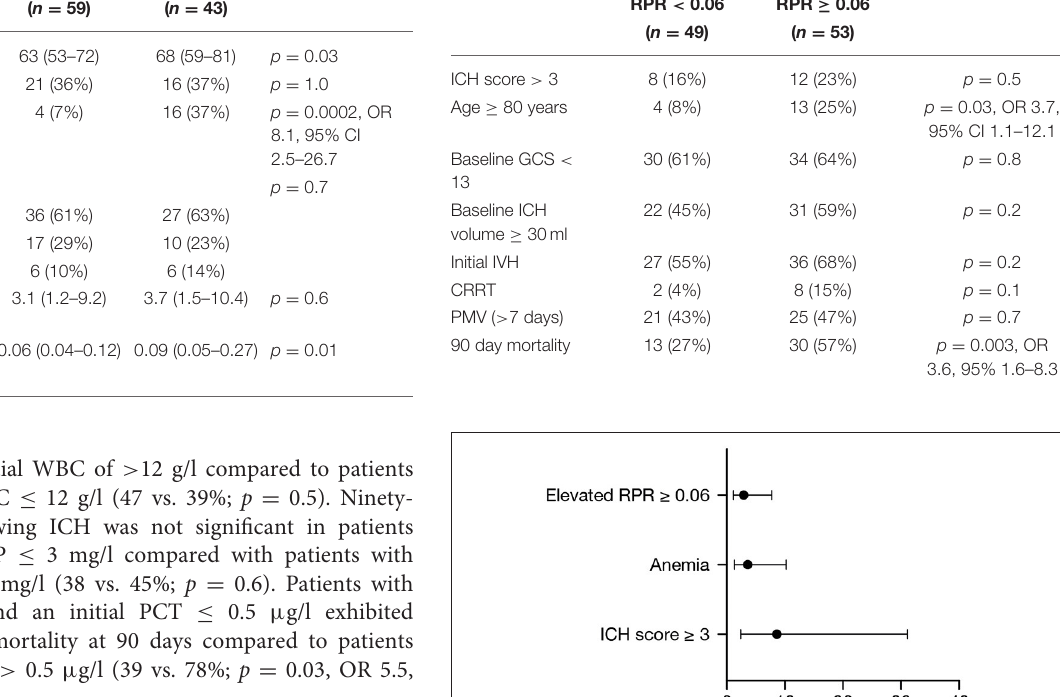
deep-seated ICH. RPR < 0.06